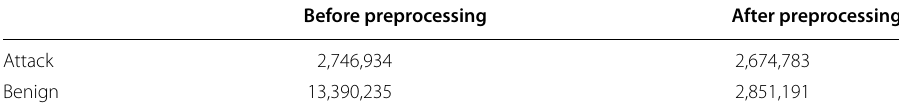
Table 4 Attack and benign samples before and after data